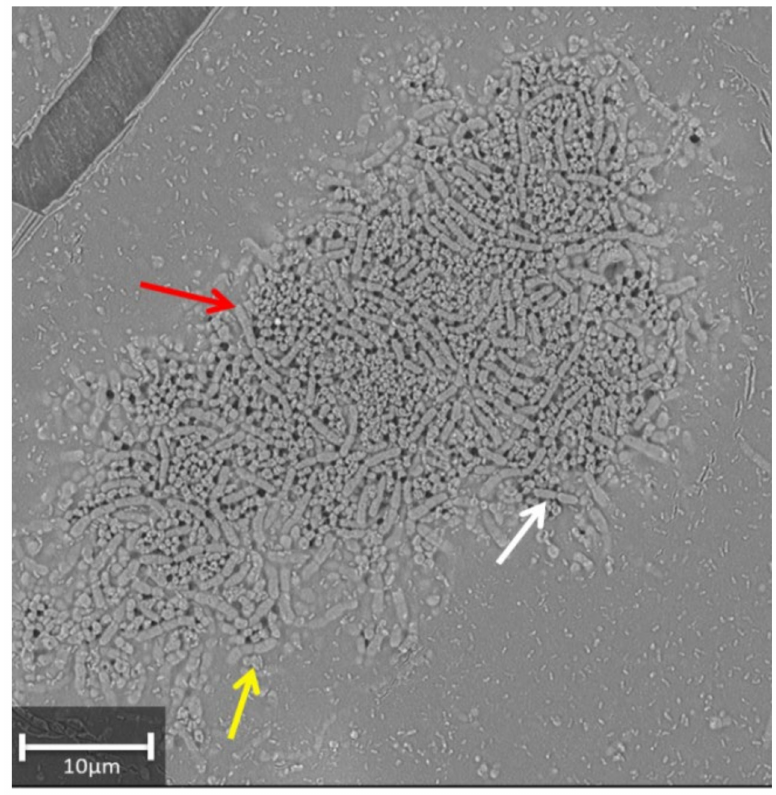
Figure 1. Observation of Bacillus aryabhattai cultivated in the presence of 1% ( v / v ) Fe-NPs by low- vacuum SEM microscopy. Red and white arrows point the rods in chains and pairs, respectively. The presence of round structures could correspond to spores (yellow